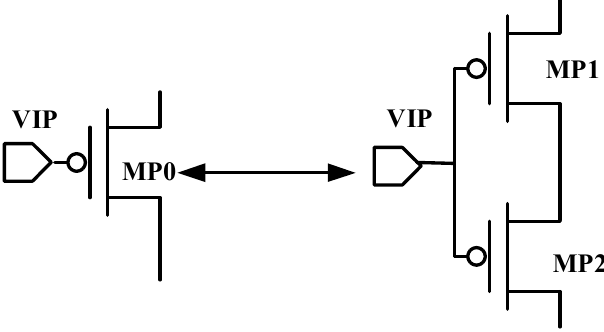
Figure 5. Principle of splitting structure.